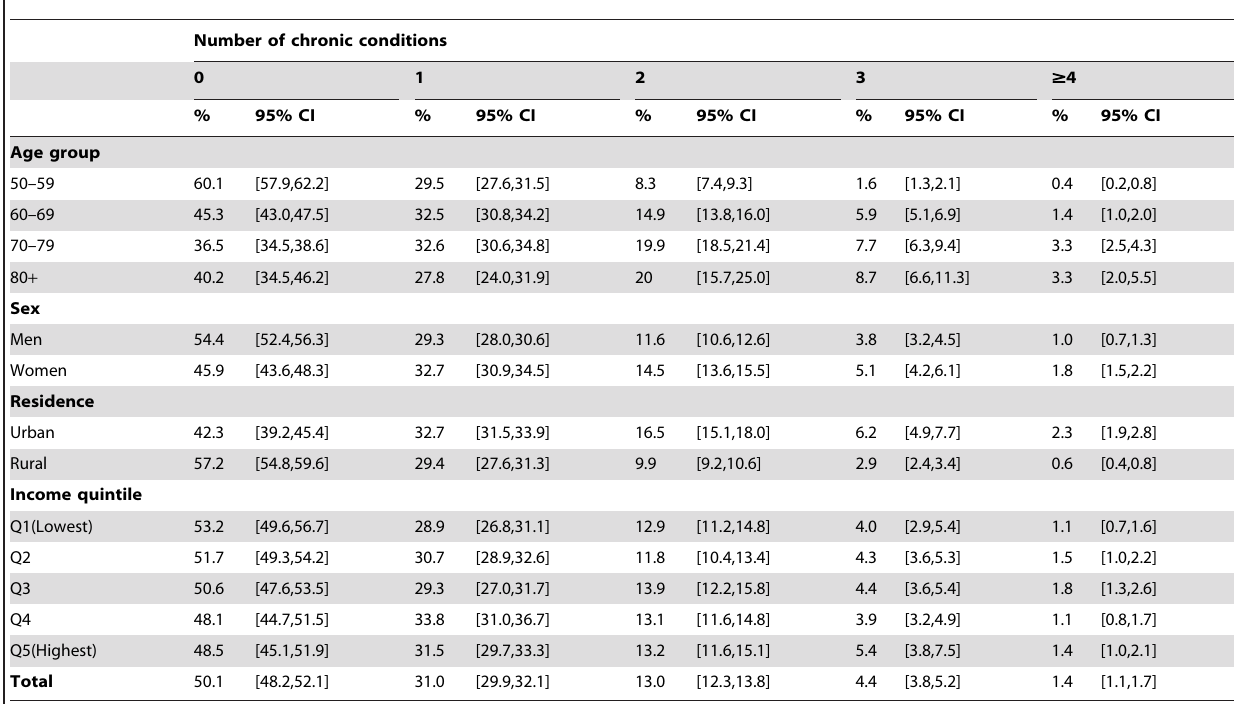
Table 3. Prevalence of having no, one and multiple chronic conditions, by age group, sex, residence and income quintile.